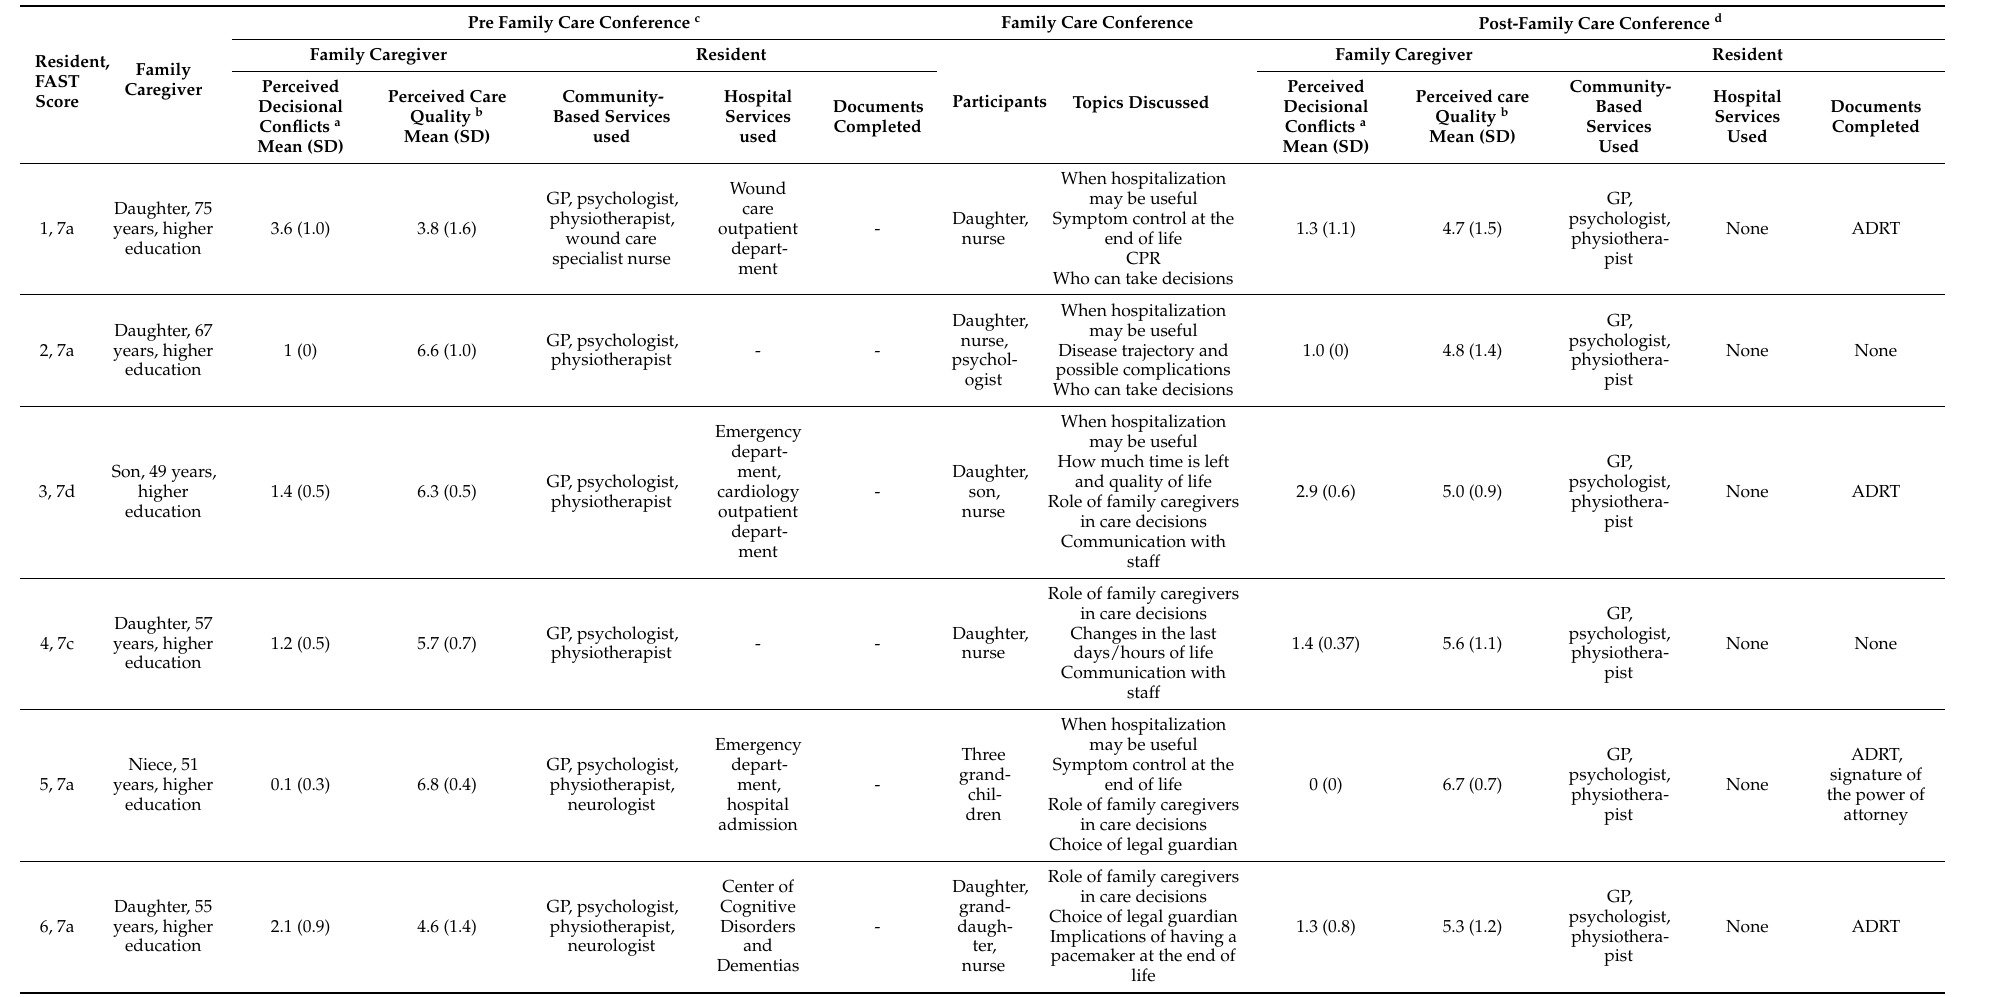
Table A2. Characteristics of the Family Care Conferences and Residents- and Family Caregivers-Related Care